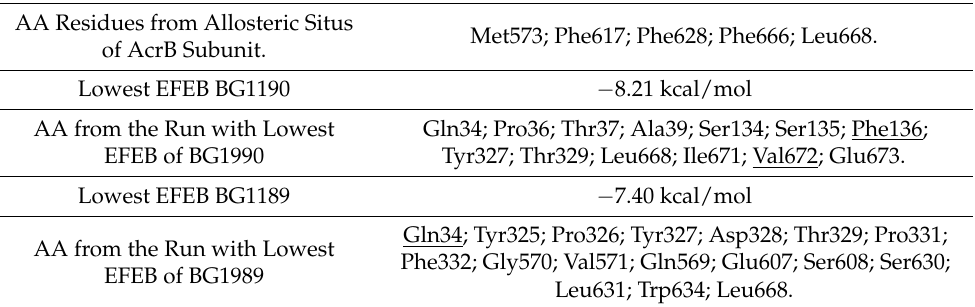
Table 3. Molecular docking results for quinazoline derivatives BG1189 and BG1190 on multidrug efflux pump subunit AcrB (PDB code: 5NC5). AA residues in h-bound with quinazoline derivatives are